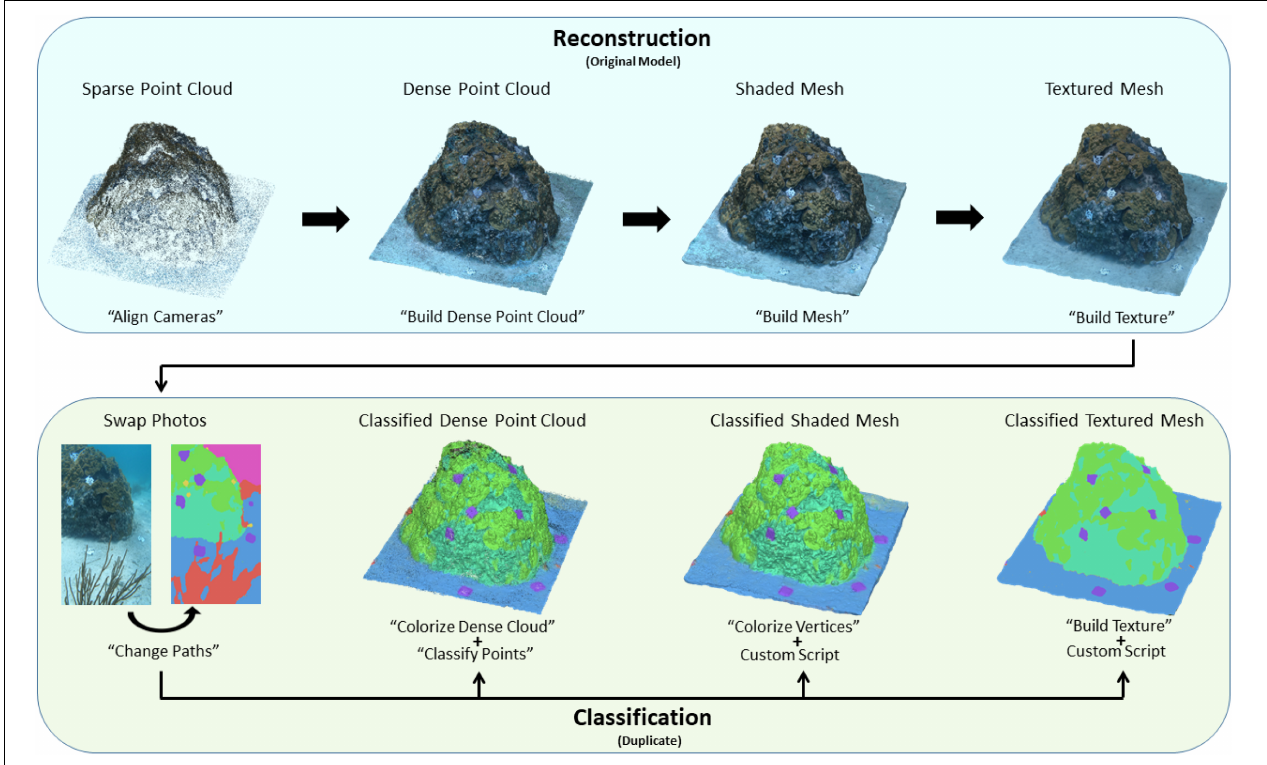
FIGURE 5 | A diagram showing step-by-step which tools in Agisoft Metashape were used to reconstruct the 3-D model, followed by how semantic labels were provided to it. Once the source images are swapped with their corresponding dense labels, the classified point cloud, shaded mesh, and textured mesh can be created independently of one another and is not a sequential process like the